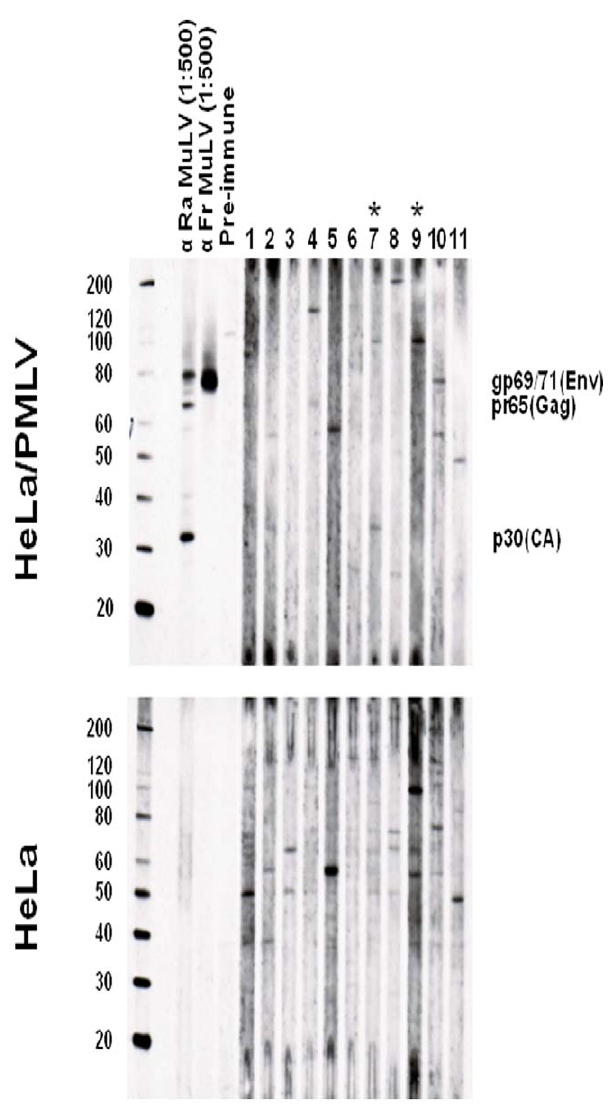
Figure 3. Absence of antibodies to XMRV and MLV in prostate cancer patients. Molecular weight markers (kD) are provided on the left of the WBs in the upper panels. Expected sizes of viral Gag (p30, capsid (CA)), pr65, and Envelope (Env, gp69/71) proteins are provided in each WB in the upper panels. Representative WB results for eleven prostate cancer patients, including patients 5956 and 6203 (indicated with asterisks). Determination of MLV specific reactivity is determined by comparison of seroreactivity to xenotropic MLV-infected HeLa antigens and uninfected HeLa antigens in upper and lower panels, respectively. Ra, Rauscher MLV whole virus goat polyclonal antisera; Fr, Friend MLV Envelope (gp69/71) goat polyclonal antisera; pre-immune, goat sera prior to immunization.